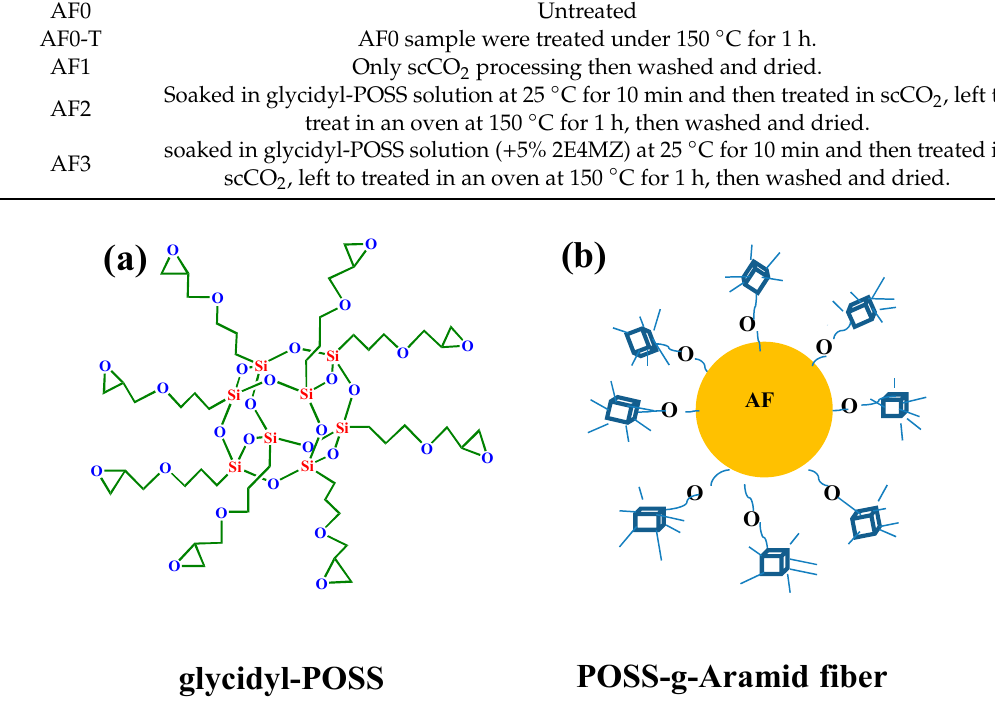
Figure 1. ( a ) Chemical structure of glycidyl-POSS. ( b ) Schematic drawing of glycidyl-POSS-AF.